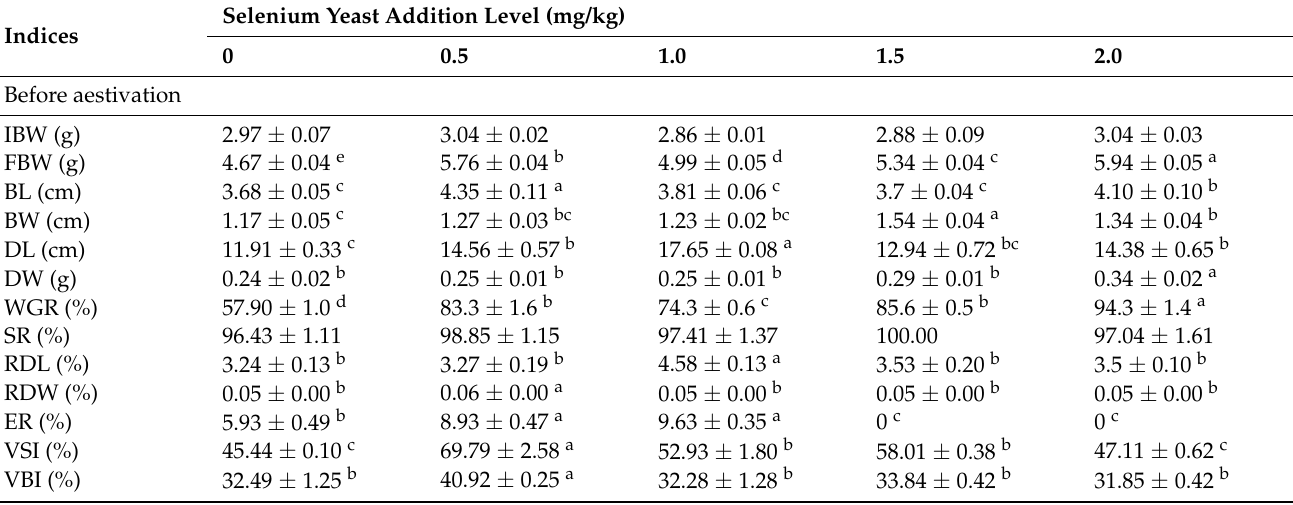
Table 3. Effects of selenium yeast addition on the growth and physiological performance of juvenile sea cucumber ( Apostichopus japonicus ) before and after aestivation (means ± SE, n =